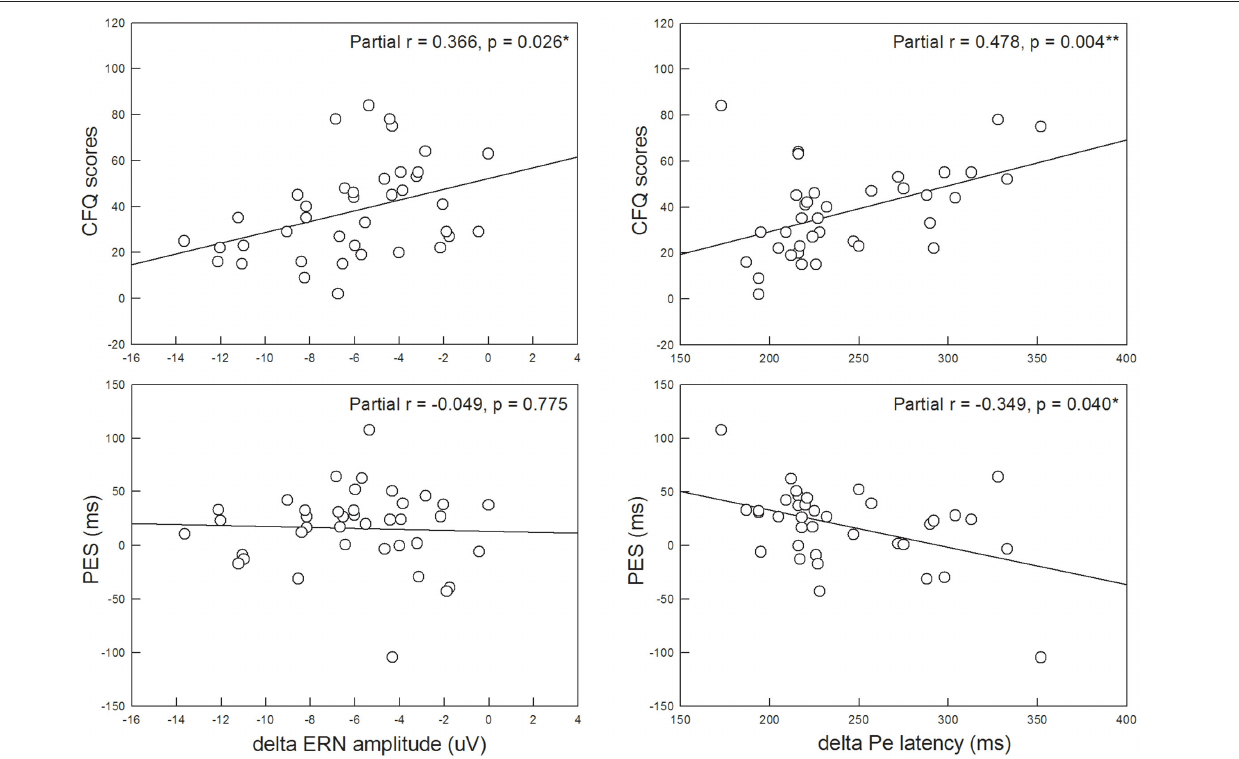
FIGURE 4 | The Cognitive Failure Questionnaire (CFQ) score was significantly associated with the 1 ERN mean amplitude and 1 Pe peak latency, suggesting that more self-reported failures in cognitive tasks are related to more reduced efficiency in error monitoring. Post-error slowing (PES) was also significantly associated with the 1 Pe peak latency, suggesting that poorer adaptive post-error adjustments are related to more deficiency in error awareness. * p < 0.05; ** p <